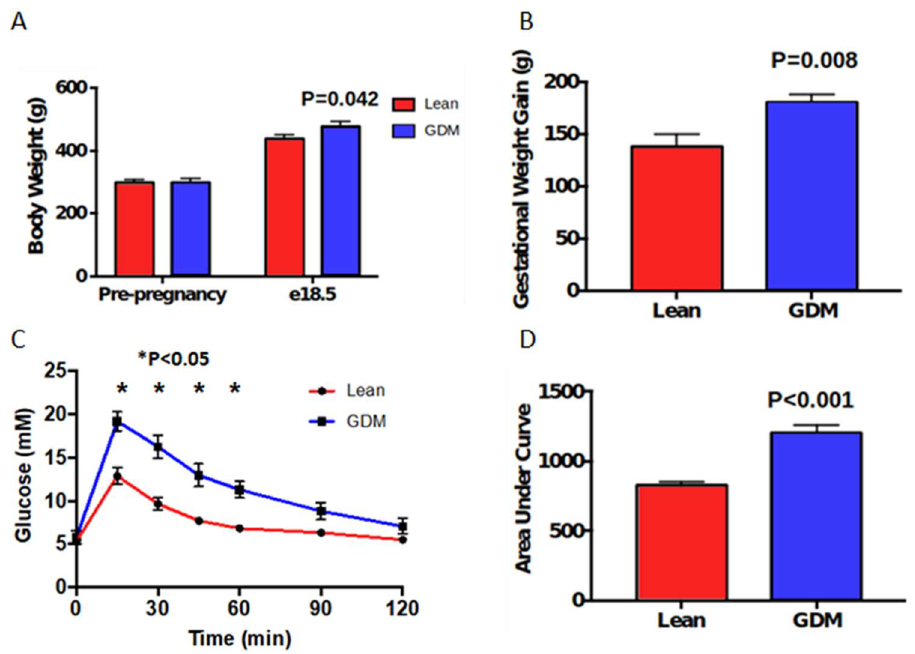
Figure 1. Maternal body composition and metabolic parameters in a rodent model of gestational diabetes mellitus (GDM). ( A ) Pre-pregnancy and late gestational (e18.5) body weight. ( B ) Gestational weight gain ( C ) Late gestational glucose tolerance test (GTT). ( D ) Area under the curve for GTT. n = 10.